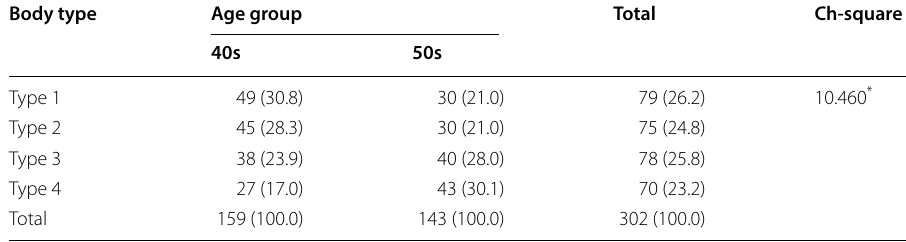
Table 14 Relationships between body types and age groups n(col.